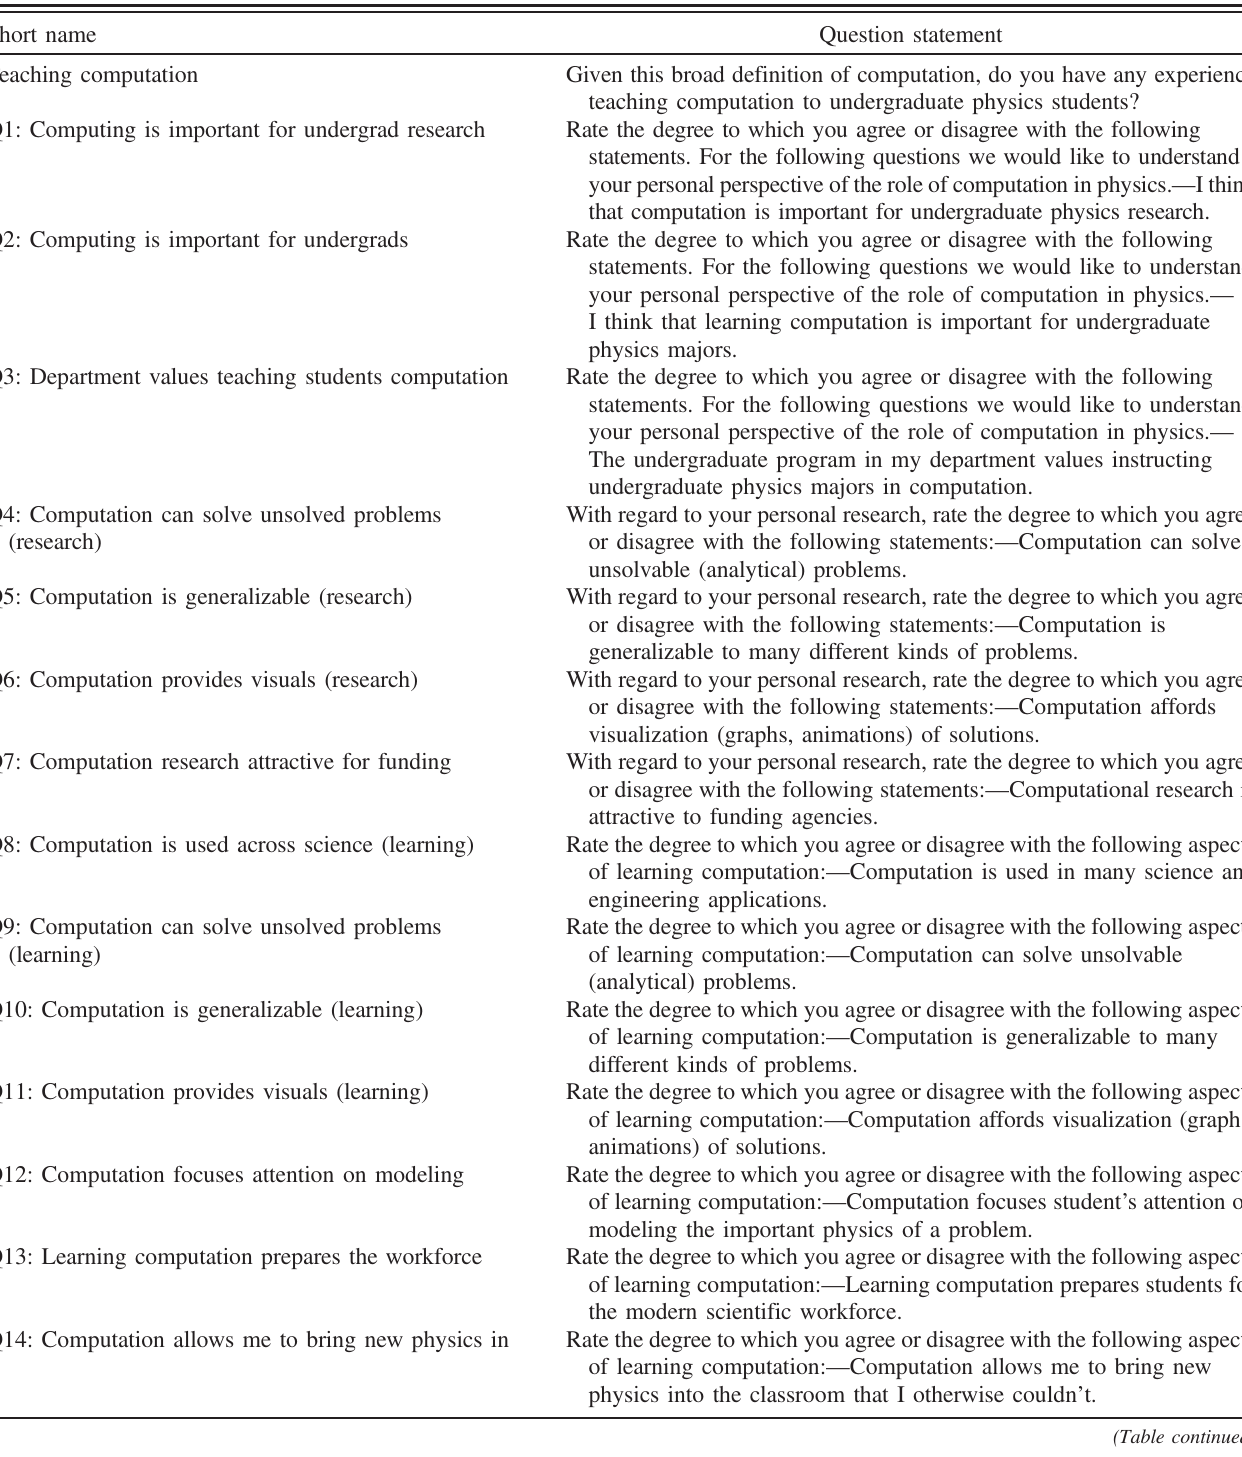
TABLE II. Full list of survey